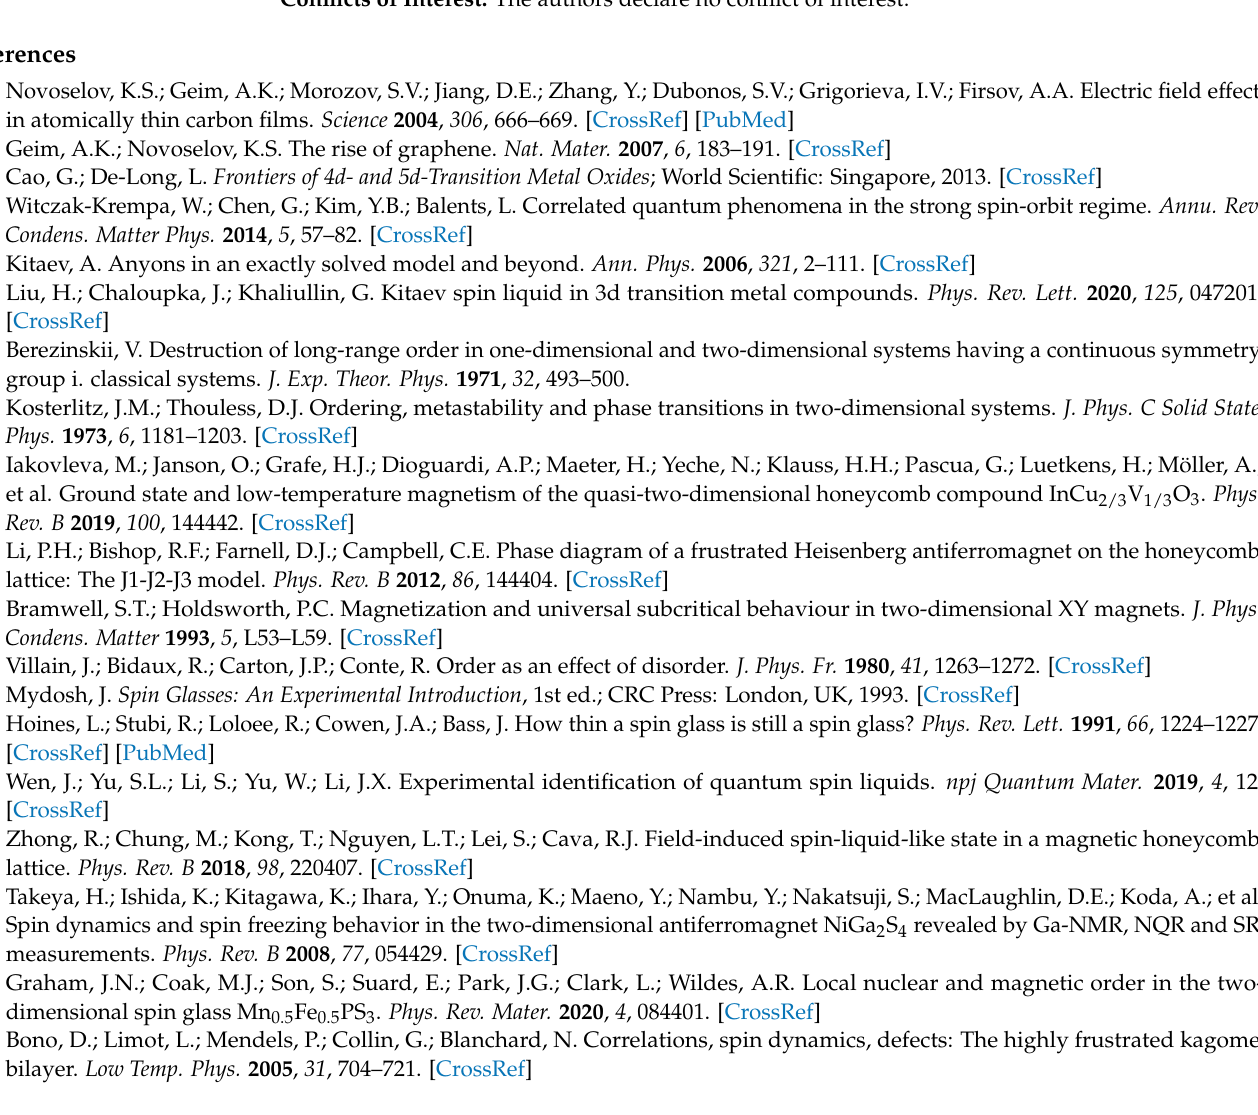
Supplementary Materials: The following are available online at https://www.mdpi.com/article/ 10.3390/ma14226785/s1, Figure S1: Results of the Rietveld refinement: XRD profile and polyhedral Table S2: Atomic positions. Table S3: Bond lengths and bond angles. References [53–55] are cited in the supplementary